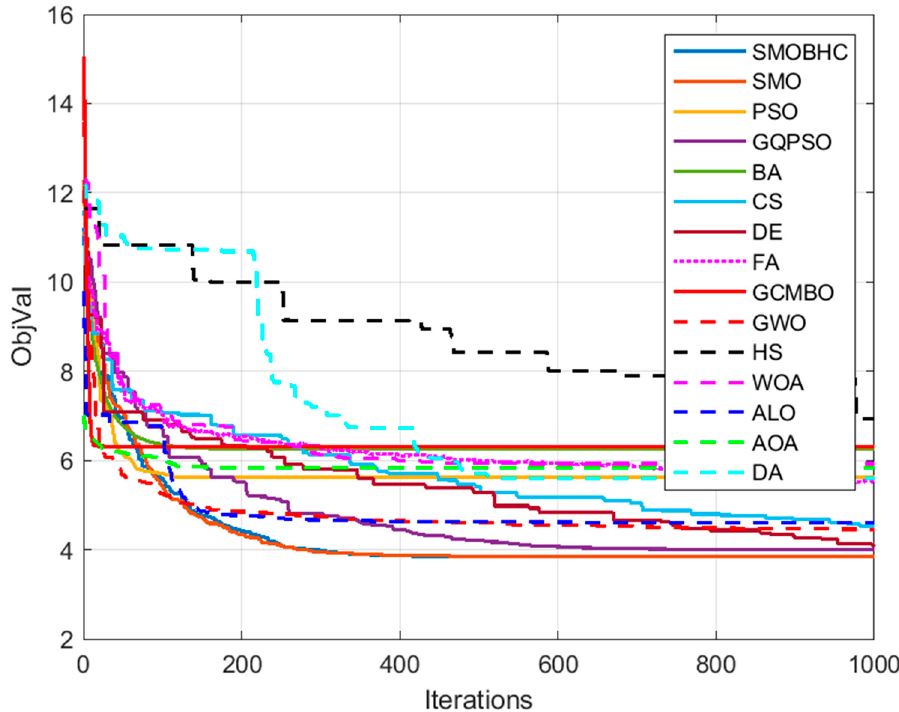
Figure 14. Comparative convergence curves of algorithms for battlefield 2 with 𝐷 = 60 .